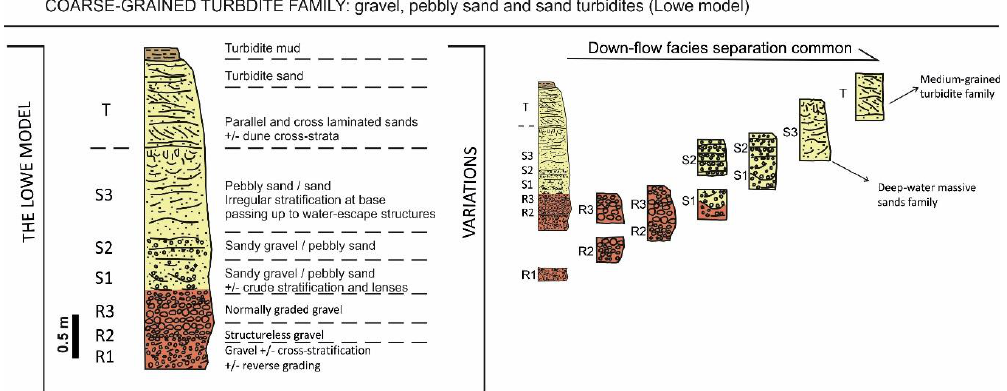
Figure 6. The coarse-grained turbidite family for gravel, pebbly sand and sandy turbidites. The ideal Lowe facies model showing the complete sequence of divisions R2–S3 [78], and typical partial sequences found commonly in nature, is given.